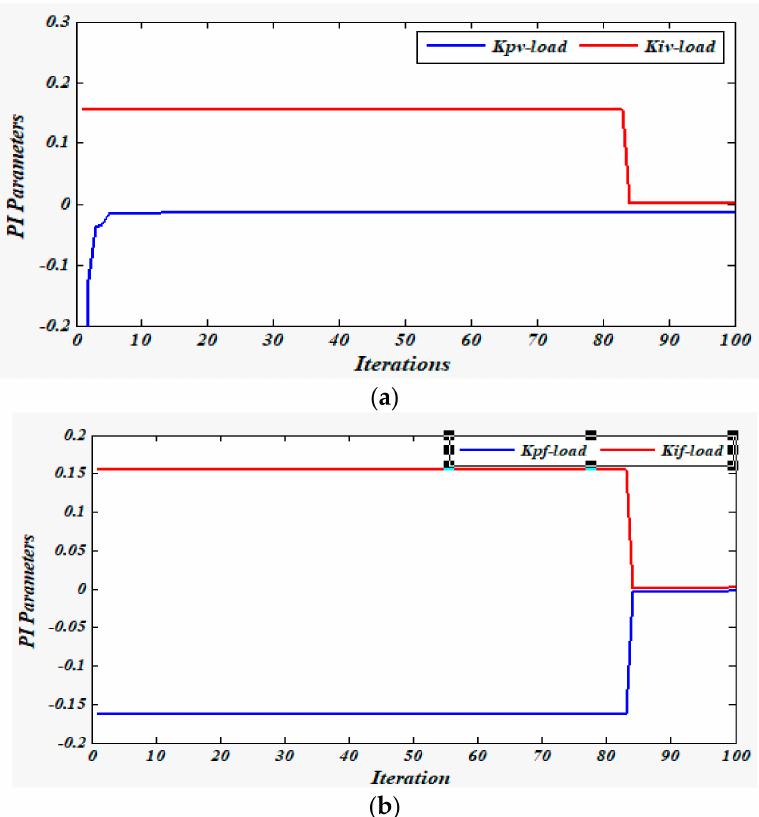
Figure 10. Optimal gain value searching process of WOA during load changing mode, ( a ) Gain values for voltage parameter, ( b ) Gain values for frequency